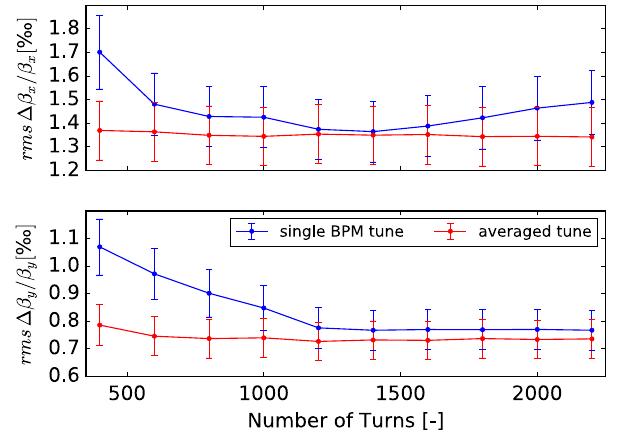
FIG. 3. Simulated rms of artificial β -beating computed by N-BPM from the same single-particle simulations of Fig. 2.